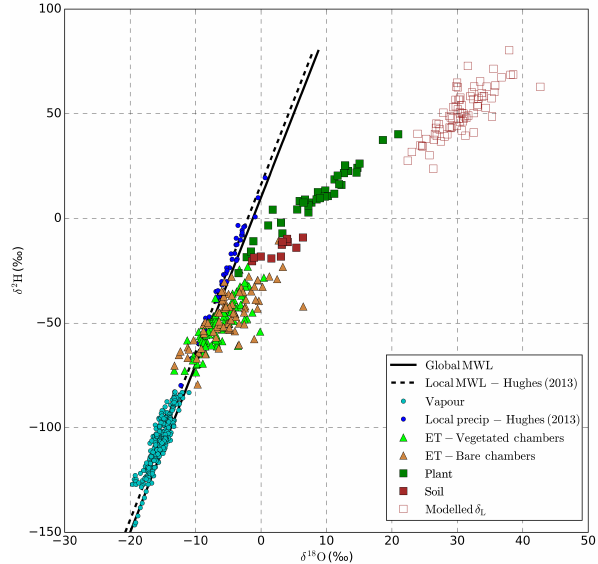
Figure 6. Relationship between δ 2 H and δ 18 O for observed and modelled water pools. Linear regressions are shown for local and global meteoric water lines (MWL). Data from Hughes and Crawford (2013) are for monthly cumulative rainfall samples be- tween 2005 and